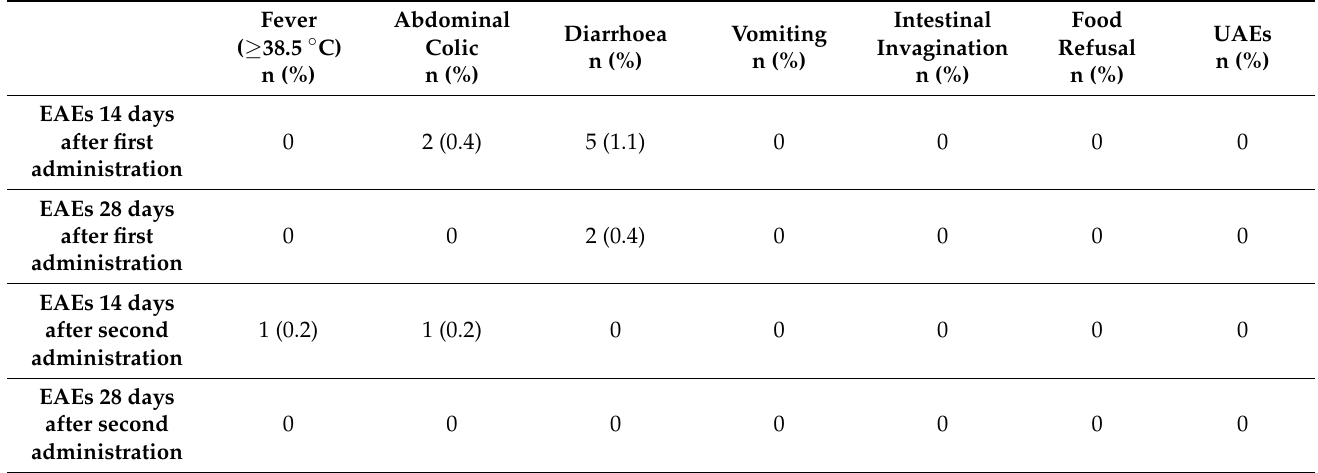
Table 3. Expected and unexpected adverse events (EAEs and UAEs) that occurred 14 and 28 days after first and second administration of monovalent rotavirus